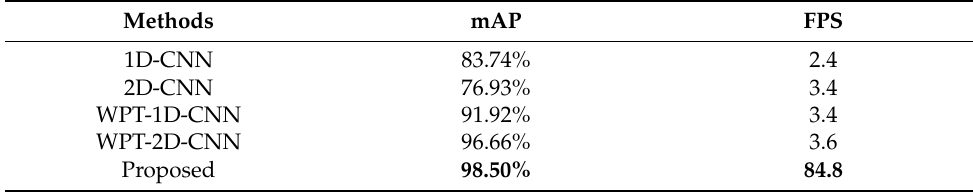
Table 4. Method comparison of different optical fiber vibration